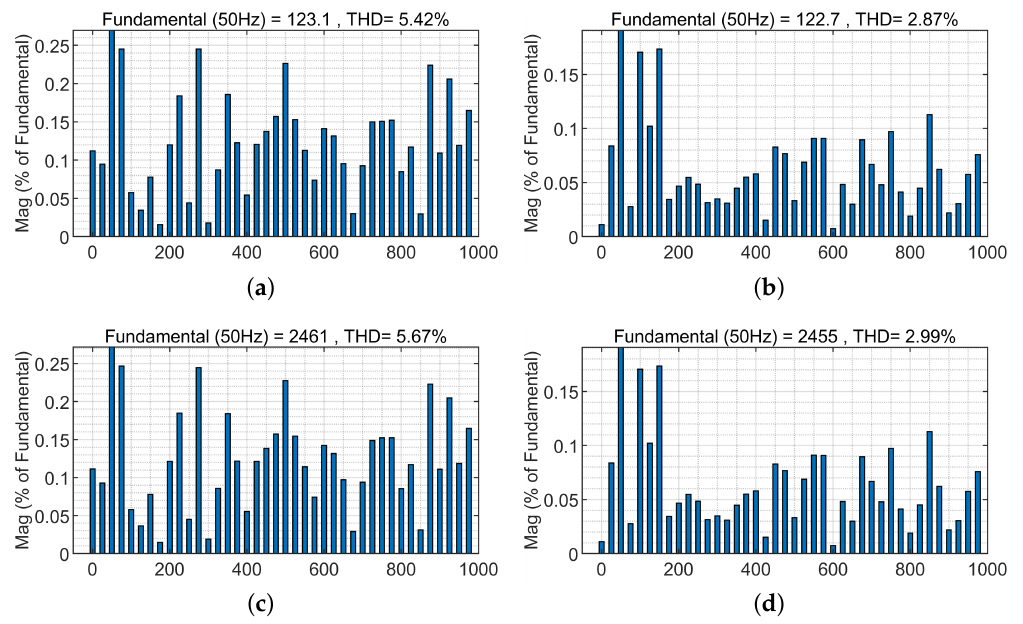
Figure 14. Output current FFT results of two case: ( a ) Output current in 5 level. ( b ) Output current in 9 level. ( c ) Output voltage in 5 level. ( d ) Output voltage in 9 level.